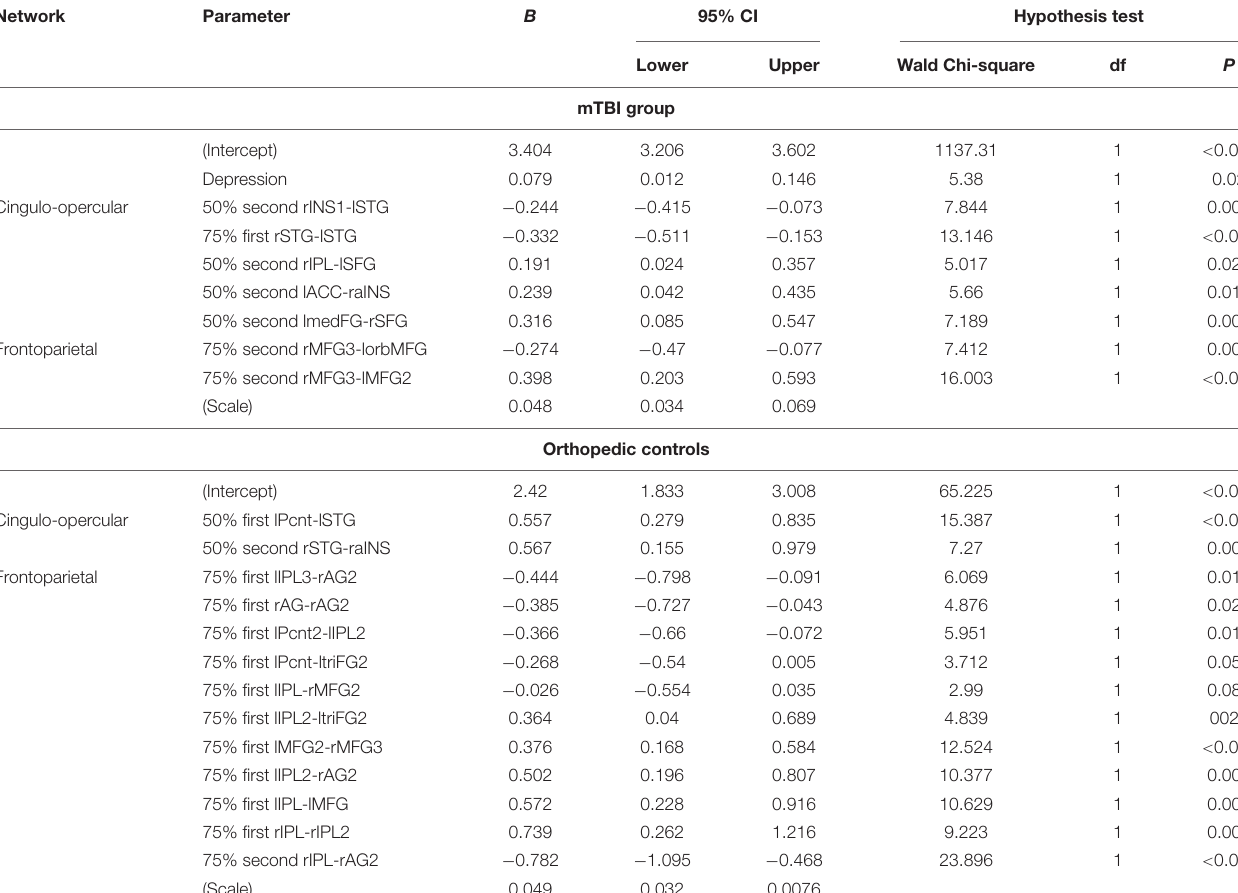
TABLE 4 | Significant predictors of Fatigue Severity Scale (FSS) in each group based on the generalized linear model with gamma (log) distribution for the FSS. Network Parameter B 95%